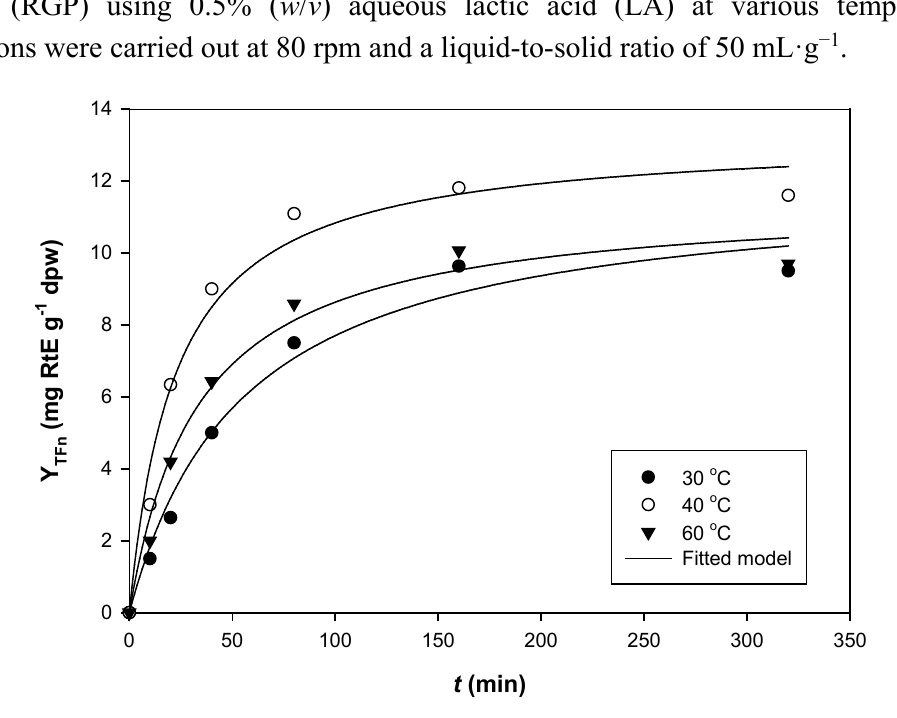
Figure 1. Time course of total flavonoid yield ( Y TFn ) during the extraction of red grape pomace (RGP) using 0.5% ( w / v ) aqueous lactic acid (LA) at various